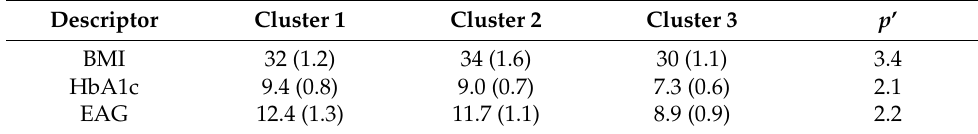
Table 4. Variables of the best k-means clustering for DPNP underlying disease.